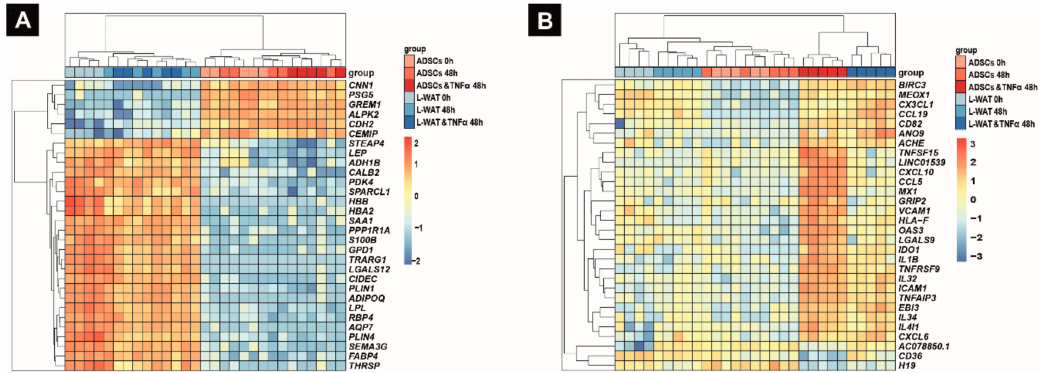
Figure 4. Hierarchical cluster analysis of the 30 most contributing genes of PC1 and PC4. The 30 most to PC1 contributing genes are fat-related marker genes including LEP , FABP4 and ADIPOQ ( A ). The analysis of the PC4 reveals the separation among genes associated with immunomodulatory processes ( B